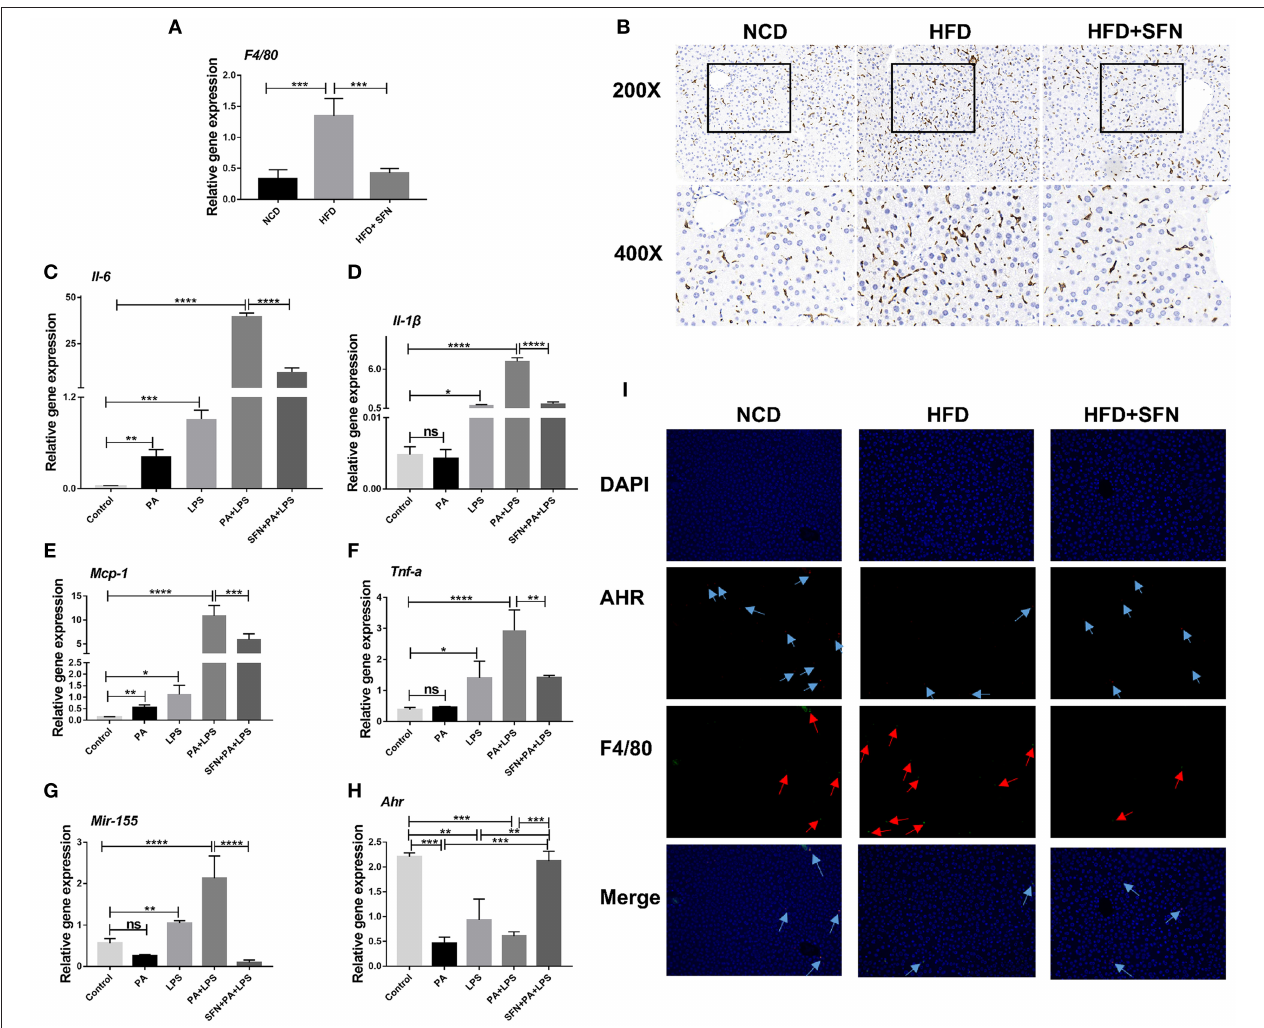
FIGURE 6 | SFN inhibited the liver inflammation effects and attenuated the expression of proinflammatory cytokines in macrophages. (A) The mRNA expression of F4/80 in the liver tissue. (B) IHC staining displayed the expression of F4/80 (brown particles), in the livers of different groups. (C–F) Changes in the expression of Il-6 , Il-1 β , Mcp-1 and Tnf-a . (G) Mir-155 expression in Raw264.7 cells. (H) mRNA expression of Ahr. (I) AHR RNA-ISH combined with F4/80 IF staining for macrophages of mouse liver sections. Arrows indicate AHR RNA and F4/80, respectively. Original magnification, 200 × . Data are presented as mean ± SD. ns, not significant, * P < 0.05, ** P < 0.01, *** P < 0.001, **** P < 0.0001 vs. the Control group or PA + LPS group or HFD